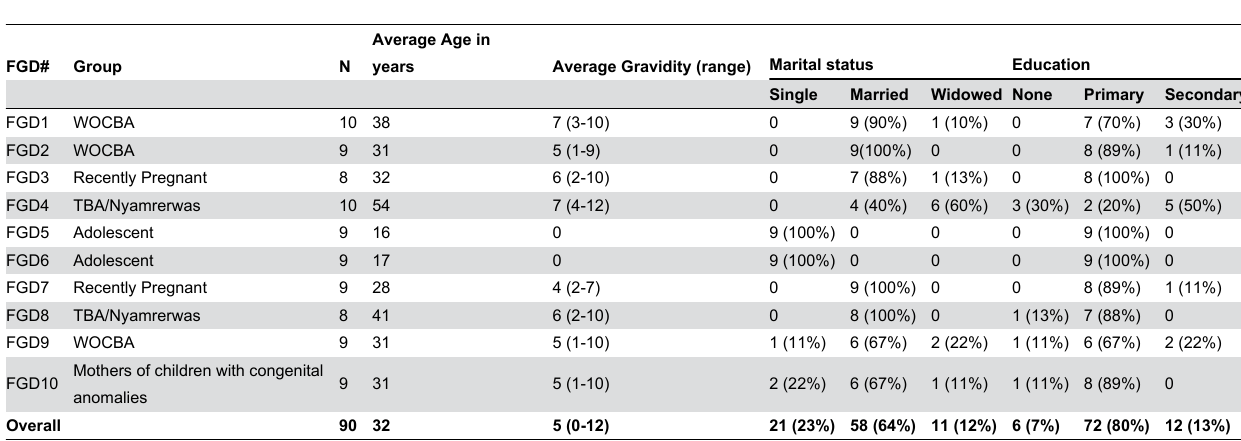
Table 1. Summary of Focus Group Discussions Participant